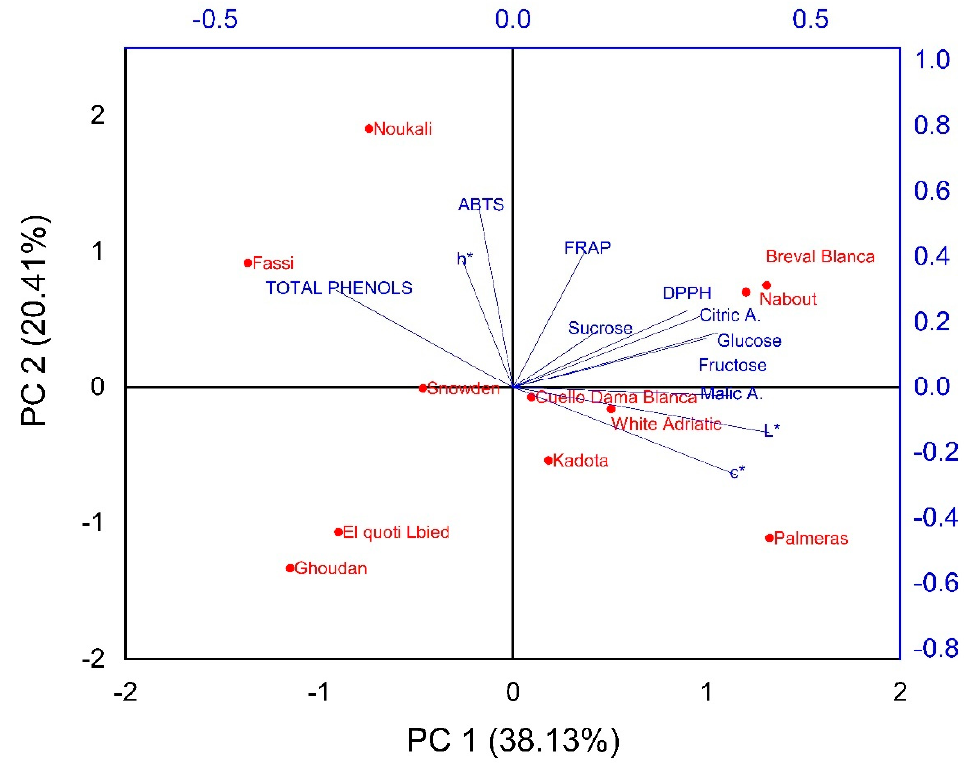
Figure 10. Biplot of scores and loadings for the PCA, constructed based on biochemical